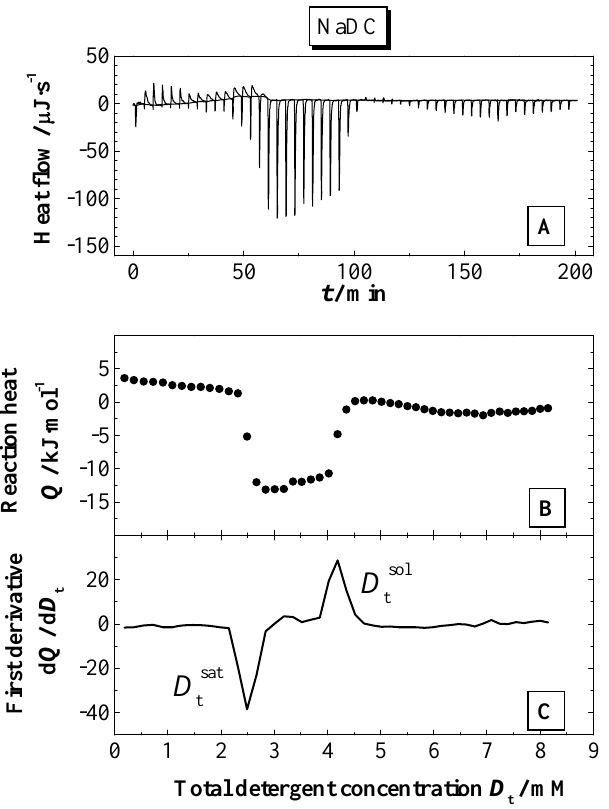
Figure 9. Solubilisation experiment: Titration of a micellar NaDC solution (50 mM) into a DPPC dispersion (6 mM) in 0.1 M NaCl, pH 7.5 at 60 ºC with 50 x 5 μ l. (A) Calorimetric traces, (B) normalised titration heat Q versus total detergent concentration in the cell D , (C) first derivative of curve t